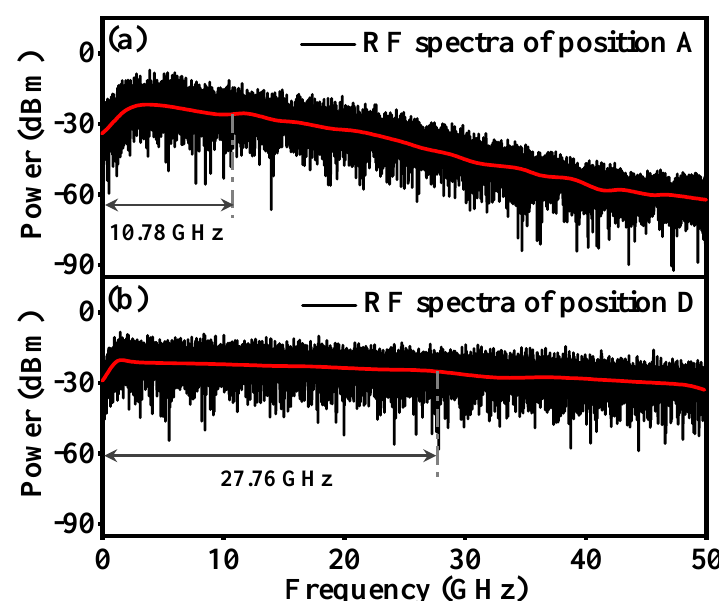
Figure 3. Measured RF spectra at ( a ) position A and ( b ) position D .